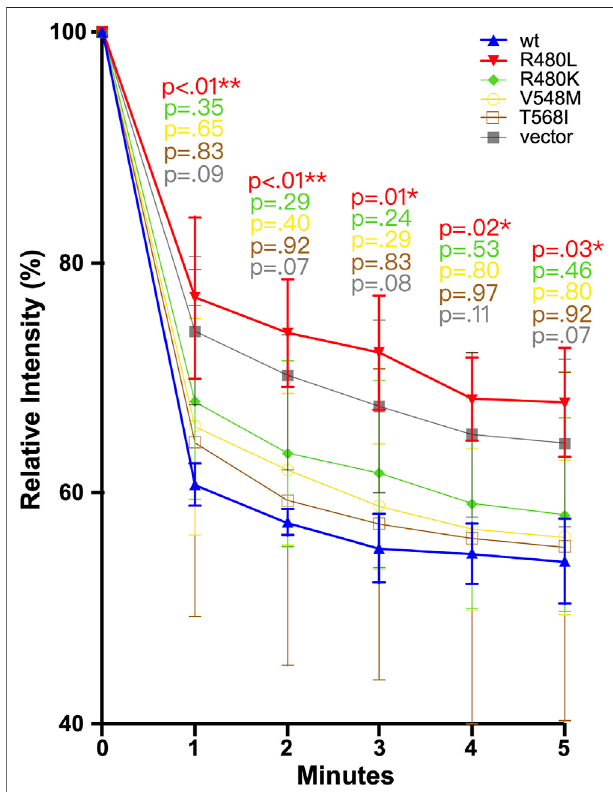
FIGURE 5 | Magnesium ef fl ux assay. mDCT cells transfected with the indicated constructs were loaded with Mg 2+ green and then subjected to the Mg depletion condition. R480L had signi fi cantly reduced Mg 2+ ef fl ux than othermutantsandwildtype.Incomparison withwild-typeandmutant, a p -value was calculated. A p -value < 0.05 is considered statistically signi fi cant. * p < 0.05, ** p < 0.01.